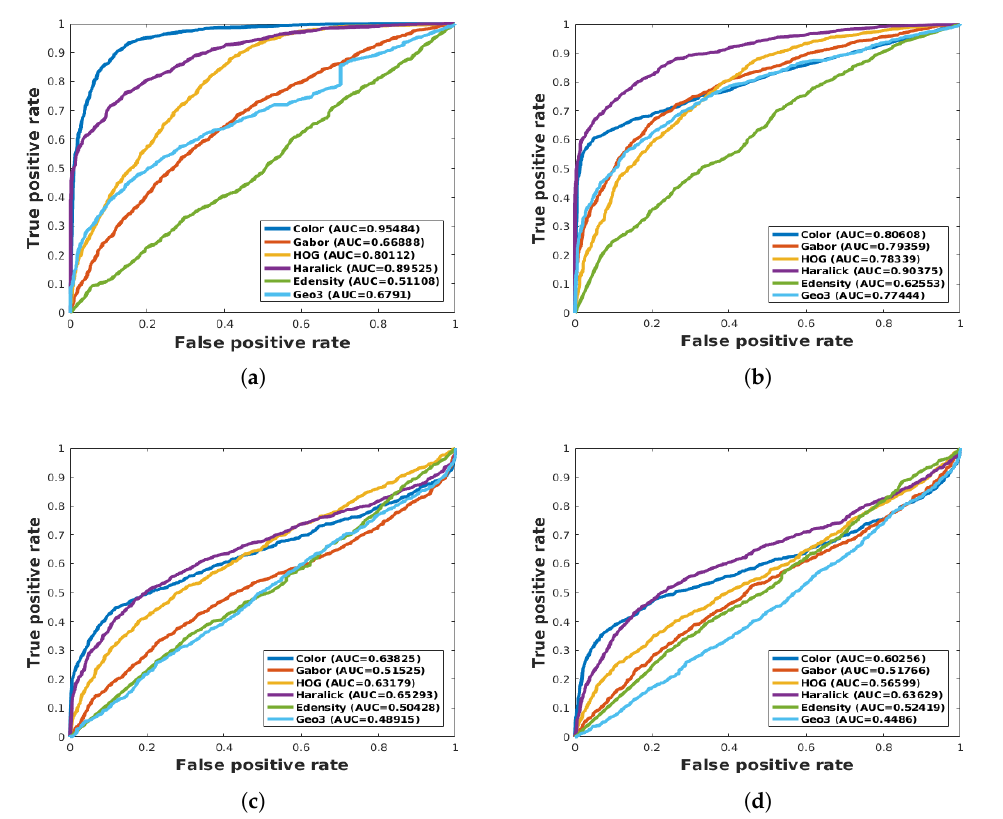
Figure 13. ROC curves of the RF models created by each feature for each field. The first line represents the spinach field and the second one is the bean field. The first and second columns are the results of the models trained on the supervised and unsupervised data,